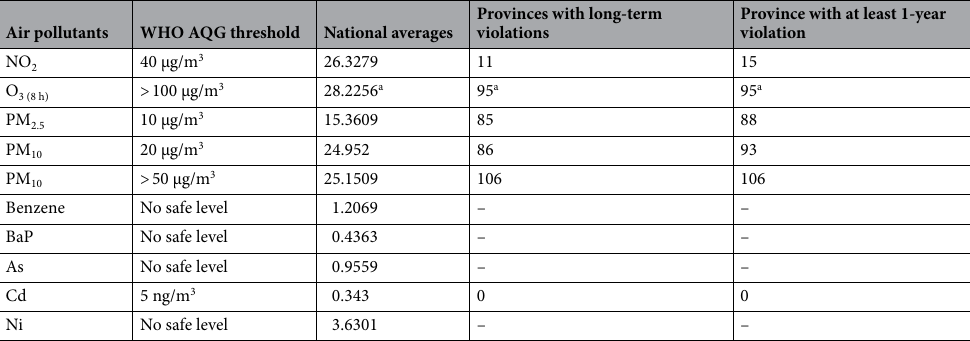
Table 3. Provinces that exceeded the WHO AQG threshold in the period 2014–2019. Source: WHO 46 . a Due to a lack of data, these violations referred to the legal threshold limit of 120 µg/m 3